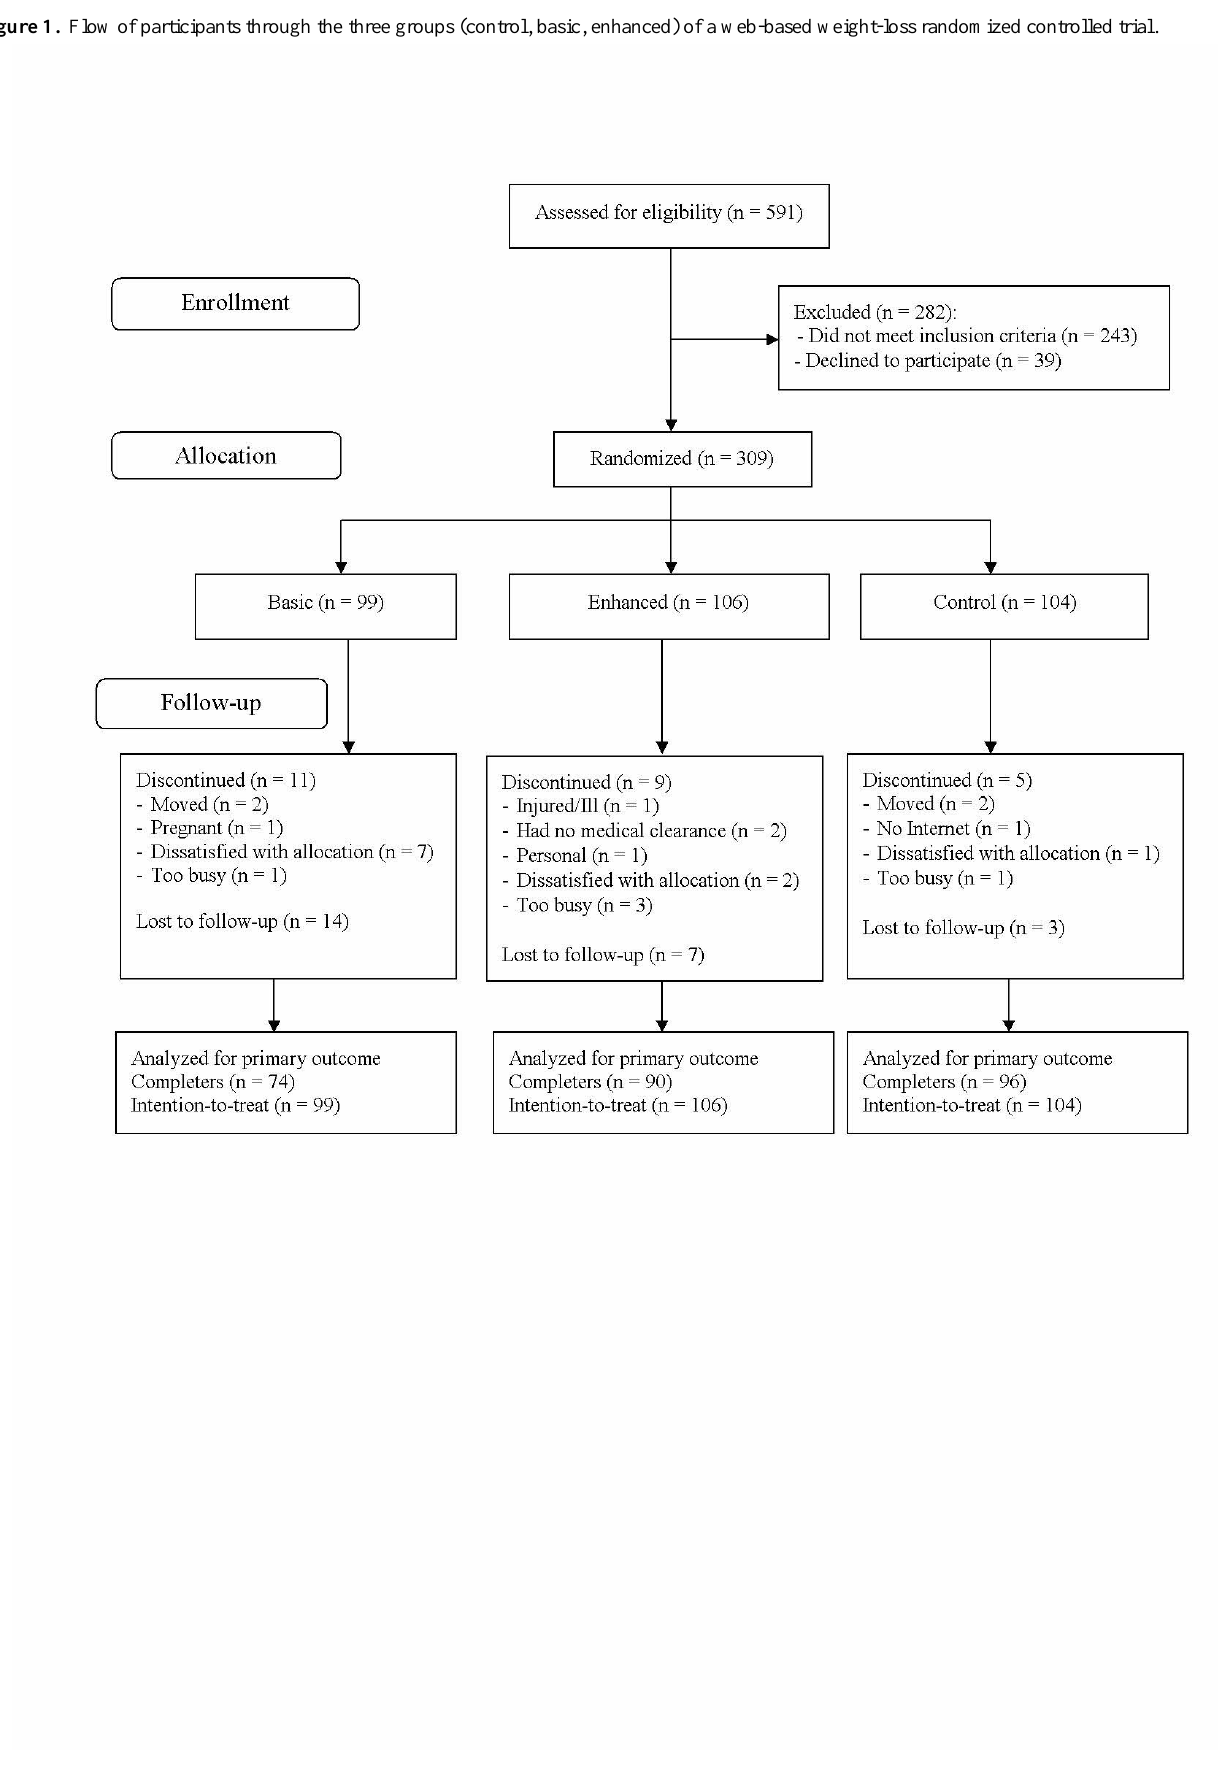
Figure 1. Flow of participants through the three groups (control, basic, enhanced) of a web-based weight-loss randomized controlled